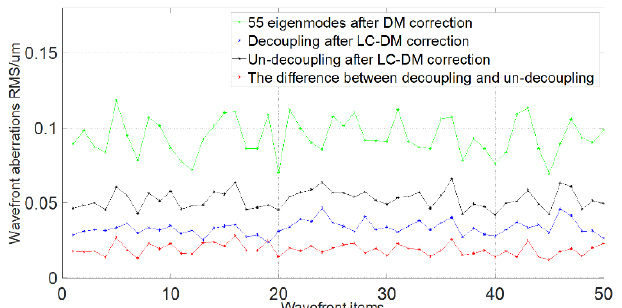
Figure 5. Curve of the wavefront correction RMS difference before and after decoupling.